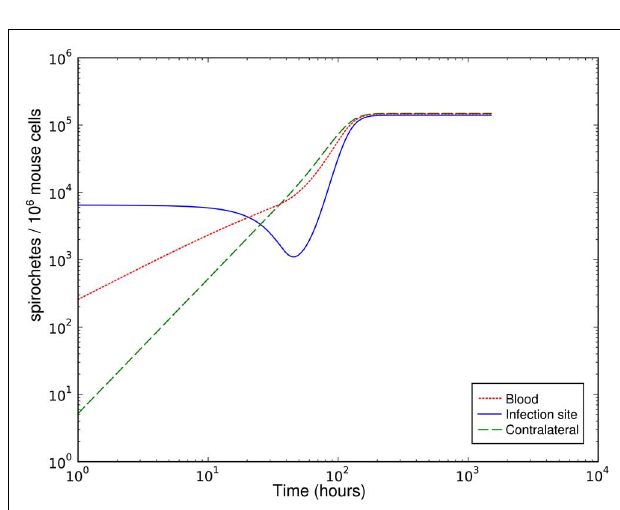
FIGURE 1 | Overview of the BB infection dynamics model based on the hematogenous migration of the bacteria. Boxes represent different compartments of the organism, circles are the considered quantities, and arrows/bars depict a stimulating/inhibiting influence of one quantity on another.The small filled circles represent death of the phagocytes. B , M : bacteria and phagocyte populations in the respective compartments, μ , ν : migration rates between the blood compartment and the two tissue sites, β :